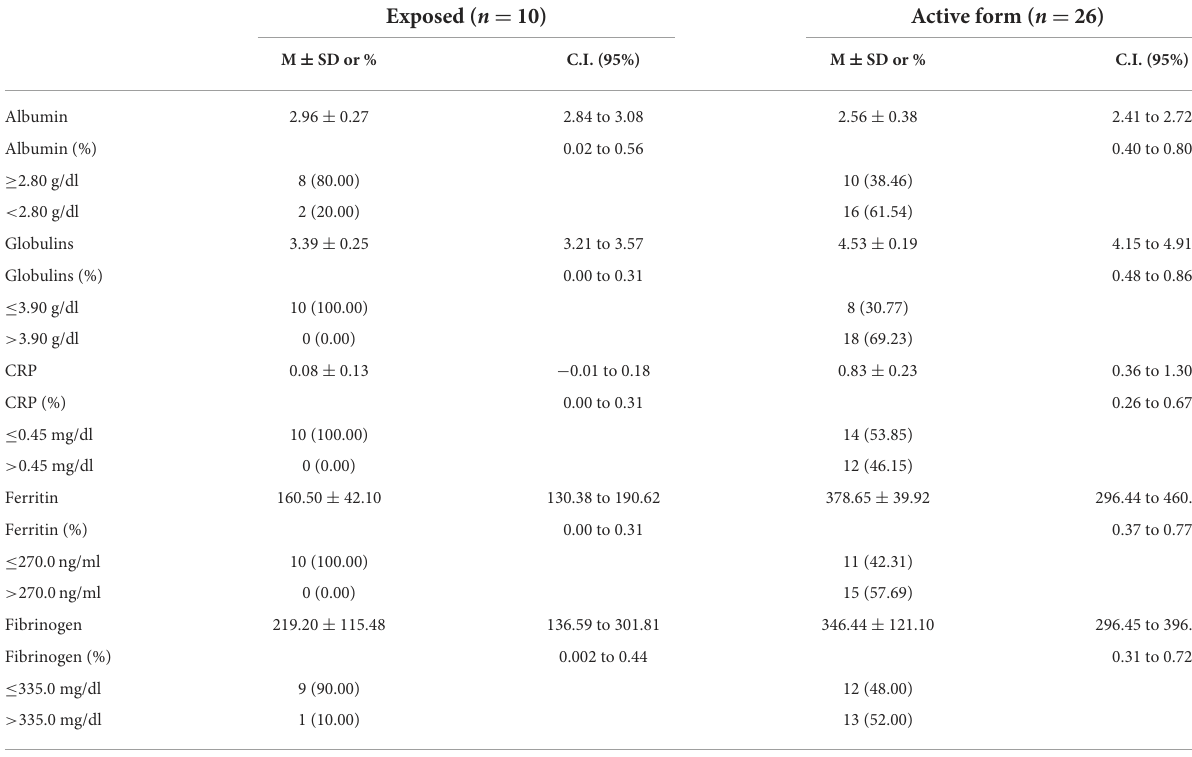
TABLE 2 Mean (M), standard deviation (SD), and confidential interval (CI) of positive and negative acute-phase proteins in exposed dogs and animals affected by a canine leishmaniosis active